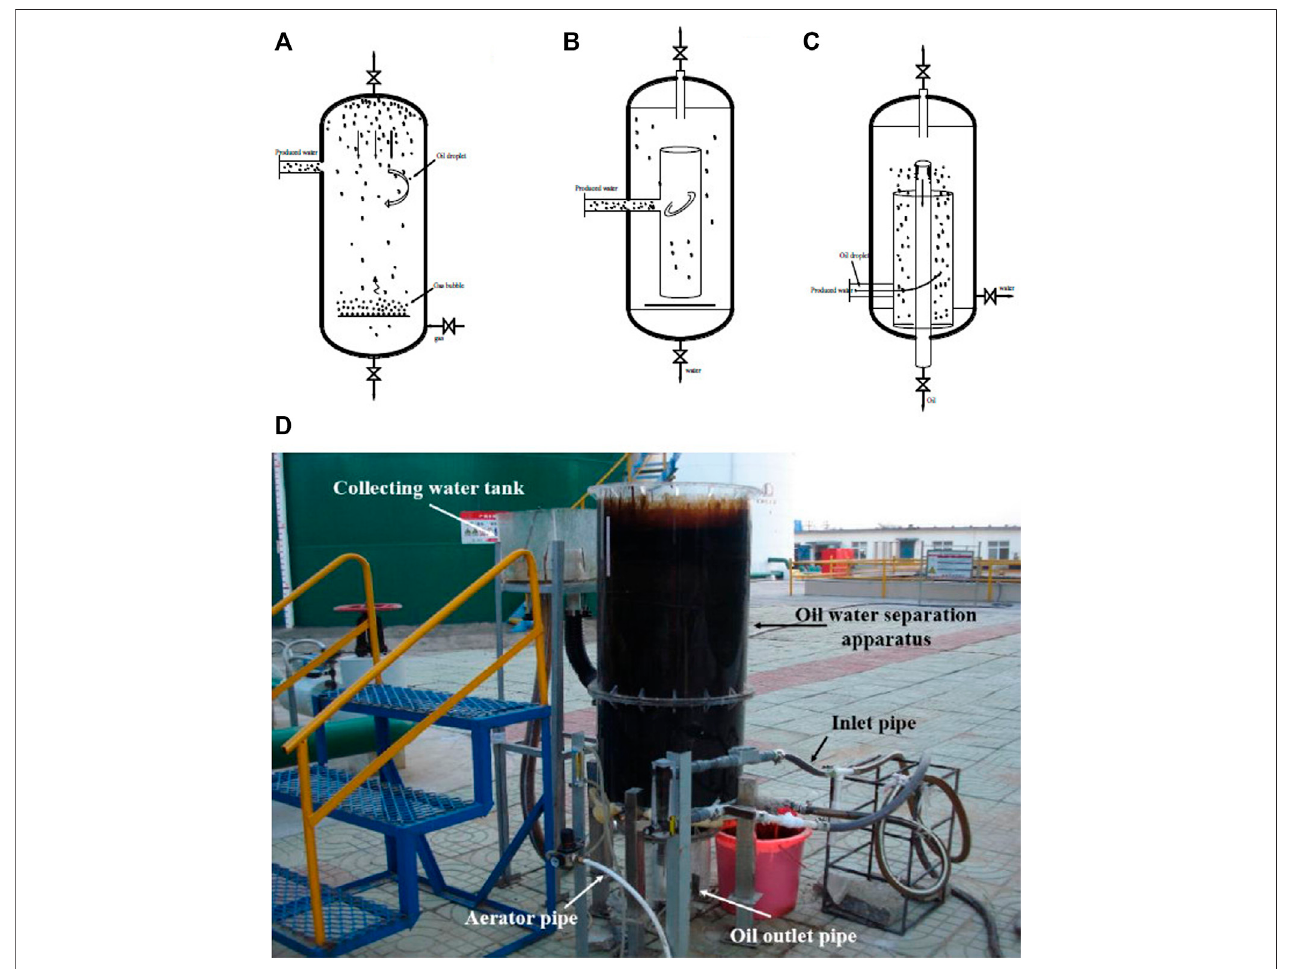
FIGURE 1 | Schematic of (A) single cylinder; (B) double cylinders; (C) triple cylinders; and (D) photo of the swirl – cyclonic fl otation